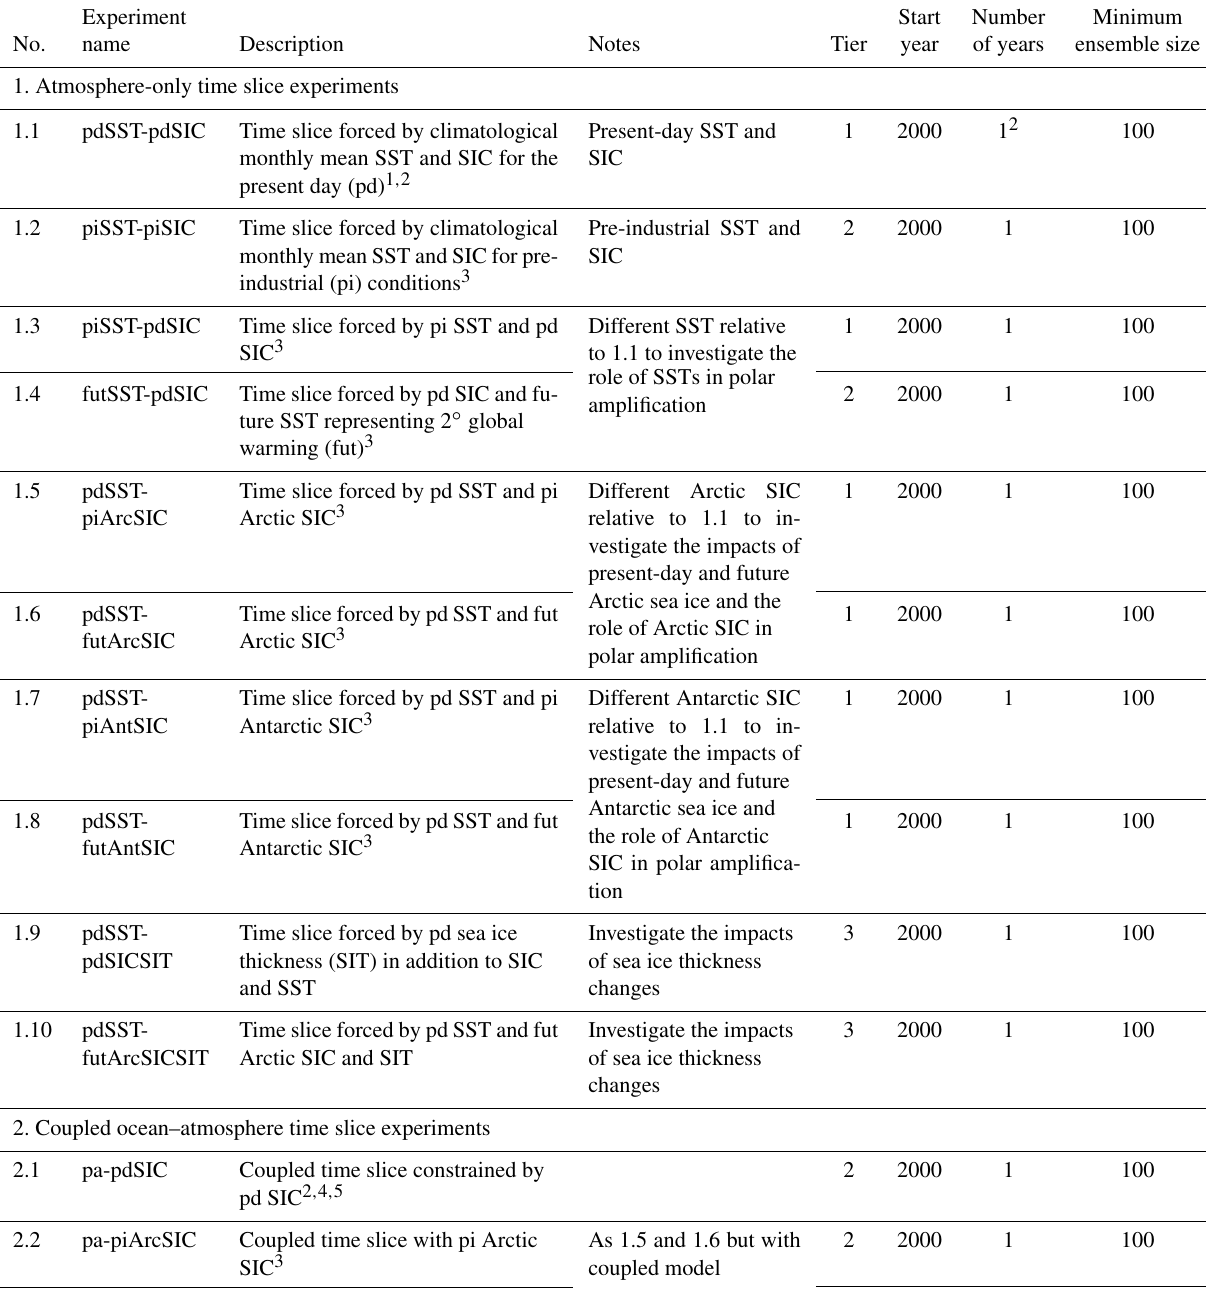
Table 1. PAMIP-coordinated model experiments. The contributions of local sea ice and remote SST to polar amplification, and the response to sea ice, will be diagnosed from atmosphere-only and coupled atmosphere–ocean model experiments using different combinations of SST and SIC representing present-day (pd), pre-industrial (pi) and future (fut, representing 2 ◦ warming) conditions. The signals of interest are obtained by differencing experiments, as shown in Table 2. Further details are given in Appendix B. The prefix “pa” denotes partially coupled experiments that are unique to PAMIP. We stress that the ensemble size is the minimum required and encourage groups to submit more members if